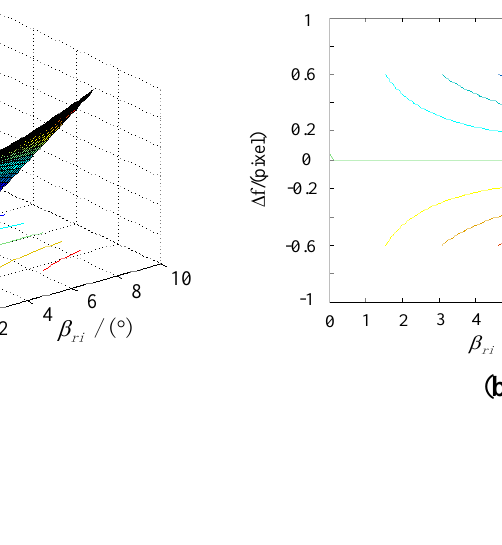
Figure 6. Influence of the focal length error on the star tracker accuracy. ( a ) is obtained when ∆f is within the range from −0.6 pixels to 0.6 pixels; ( b ) is the contour line of